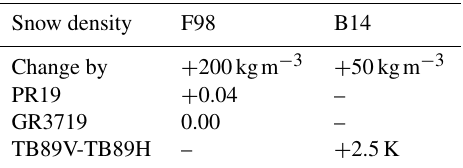
Table 2. Typical values of changes in brightness temperature due to changes in snow density. For abbreviations TB, PR, GR, V, and H see Table 1. Abbreviations F98 and B15 refer to Fuhrhop et al. (1998) and Beitsch (2014), respectively. Snow density F98 B14 Change by + 200kgm − 3 + 50kgm − 3 PR19 + 0.04 – GR3719 0.00 – – +